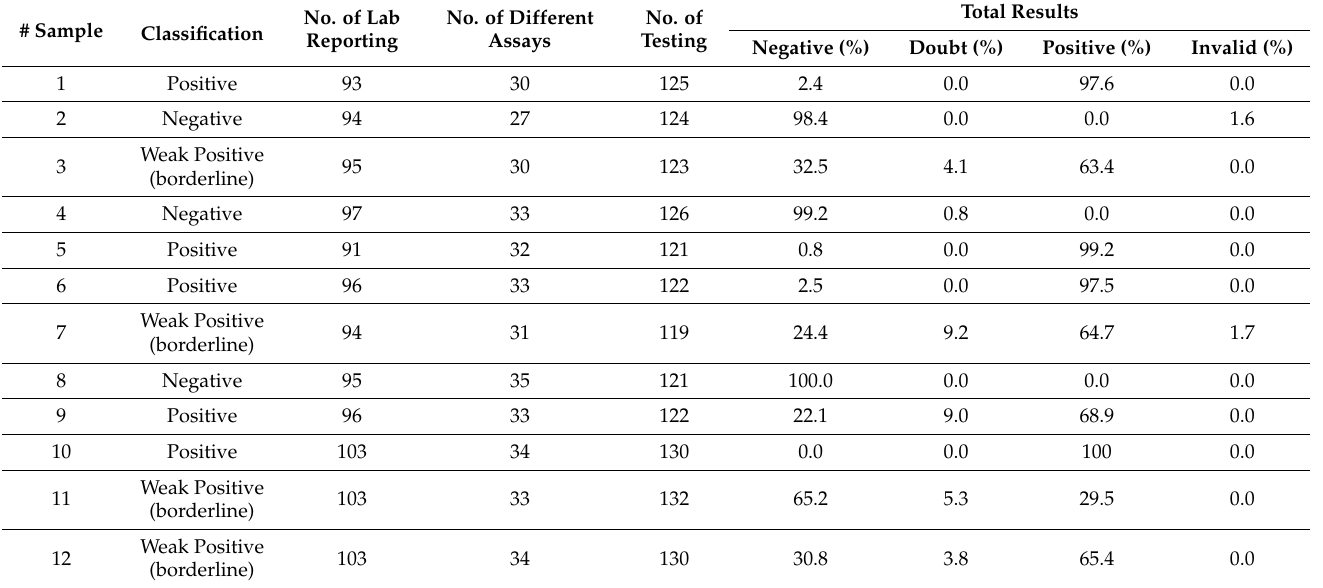
Table 3. Number of laboratories reporting, number of assays, number of reported testing and results of SARS-CoV-2 direct antigens detection